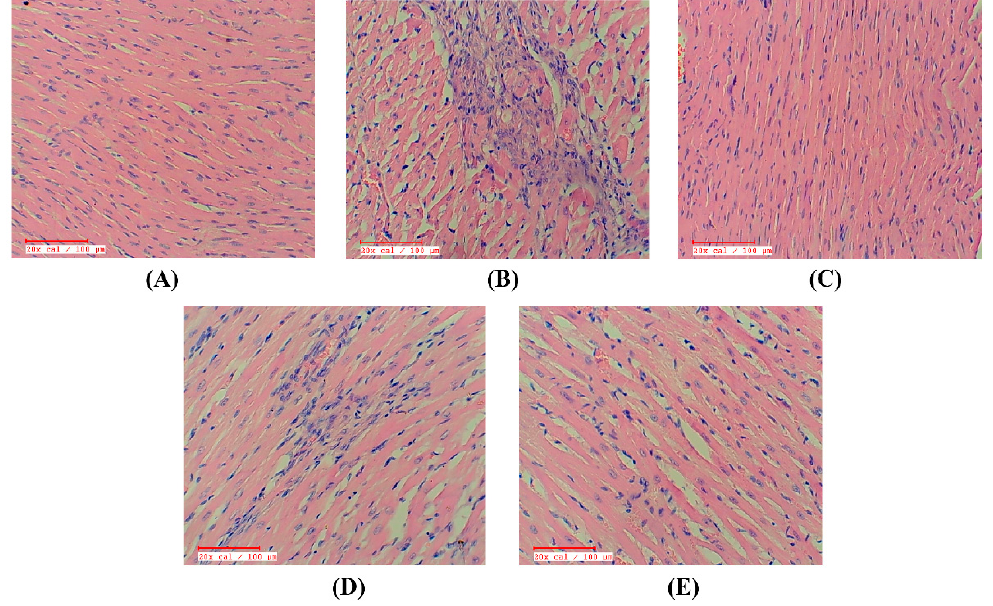
Figure 8. Effect of apigenin on histopathology in STZ–isoproterenol treated rats. ( A ) Diabetic control; ( B ) Diabetic isoproterenol; ( C ) Diabetic isoproterenol + apigenin; ( D ) Diabetic isoproterenol + GW9662; ( E ) Diabetic isoproterenol + GW9662 + apigenin. Scale bar: 100 µm.